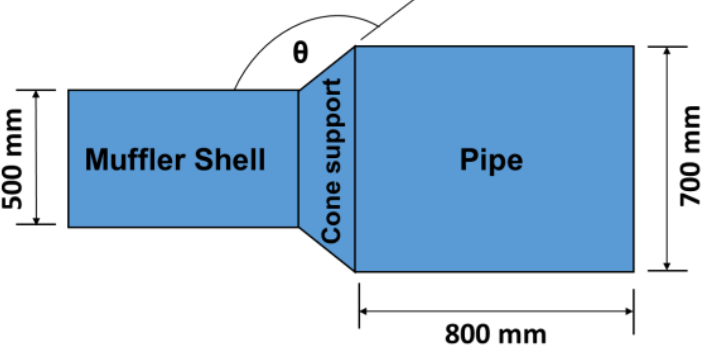
Figure 11. The muffler structure.